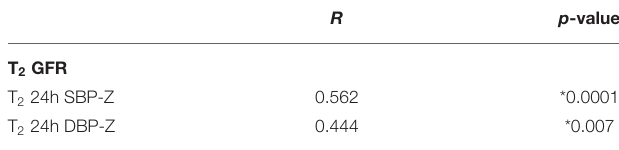
TABLE 5A | Correlation between T 2 GFR and T 2 ABPM.